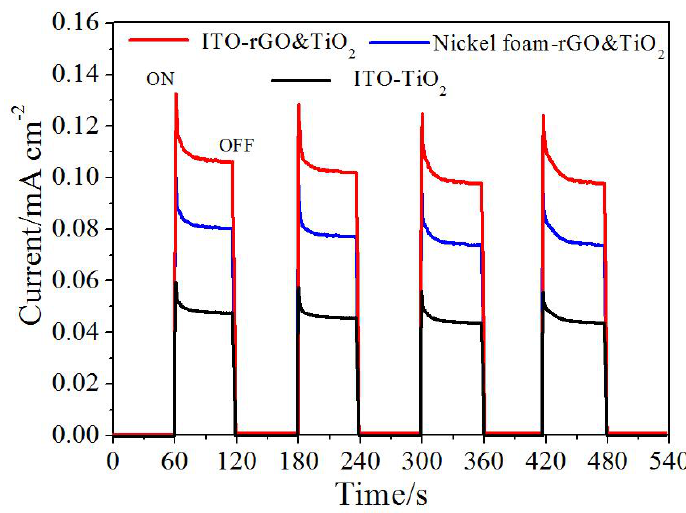
Figure 9. Transient photocurrent density of TiO 2 , Nickel foam-rGO and TiO 2 , and ITO-rGO and TiO 2 .